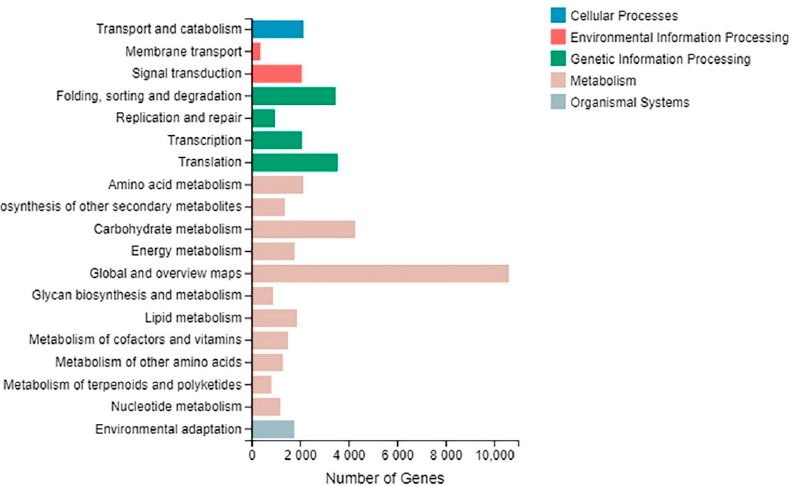
Figure 5. The KEGG pathway classification of assembled unigenes. The x -axis indicates the number of unigenes and y -axis indicates the function classes. To classify orthologous gene products, 47,369 unigenes (60.24% of all unigenes) were divided into 25 KOG classifications (Figure 6, Table S4). Among them, ‘general function